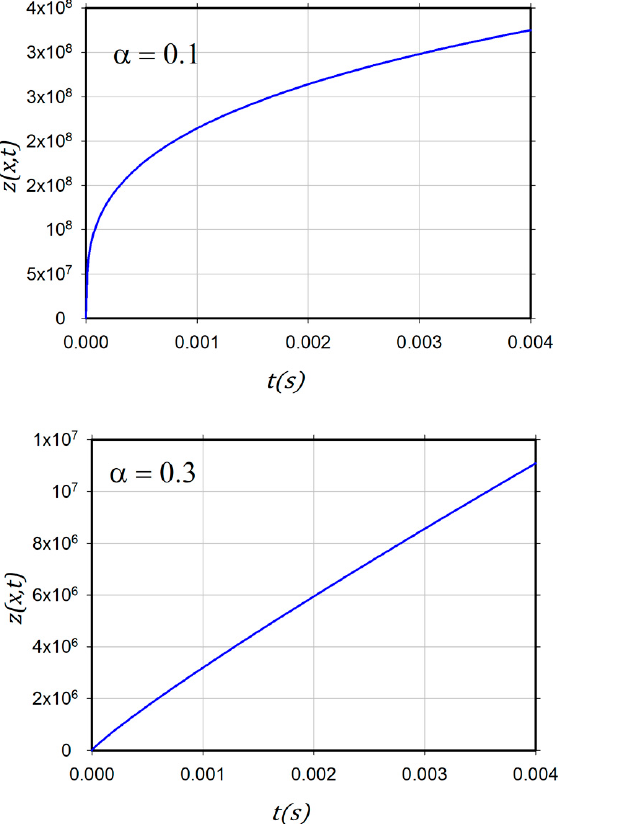
Figure 2. 3D graphs of neutron flux 𝑧(𝑥, 𝑡) for α = 0.1, 0.2, 0.3, 0.4 and 𝑧 (cid:2868) (𝑥) = 𝑥 (cid:2870) . The introduced figures of the neutron fluxes for various values of 𝛼 in case 𝑧(𝑥, 0) = 1 and case 𝑧(𝑥, 0) = 𝑥 (cid:2870) demonstrate that the results matched those of the ADM [35]. Finally, as can be seen from the tables and figures, the ARA-RPST gives us more details regarding the neutron flux in non-Gaussian diffusion for a variety of chosen times. 5. Conclusions The ARA-RPST is introduced to construct a fractional series solution of NDEDNS. Two different nuclear physics numerical case studies have validated the theoretical presentation of the method, and additionally, the results are validated when they are compared with the ADM. It should be mentioned that the suggested technique is